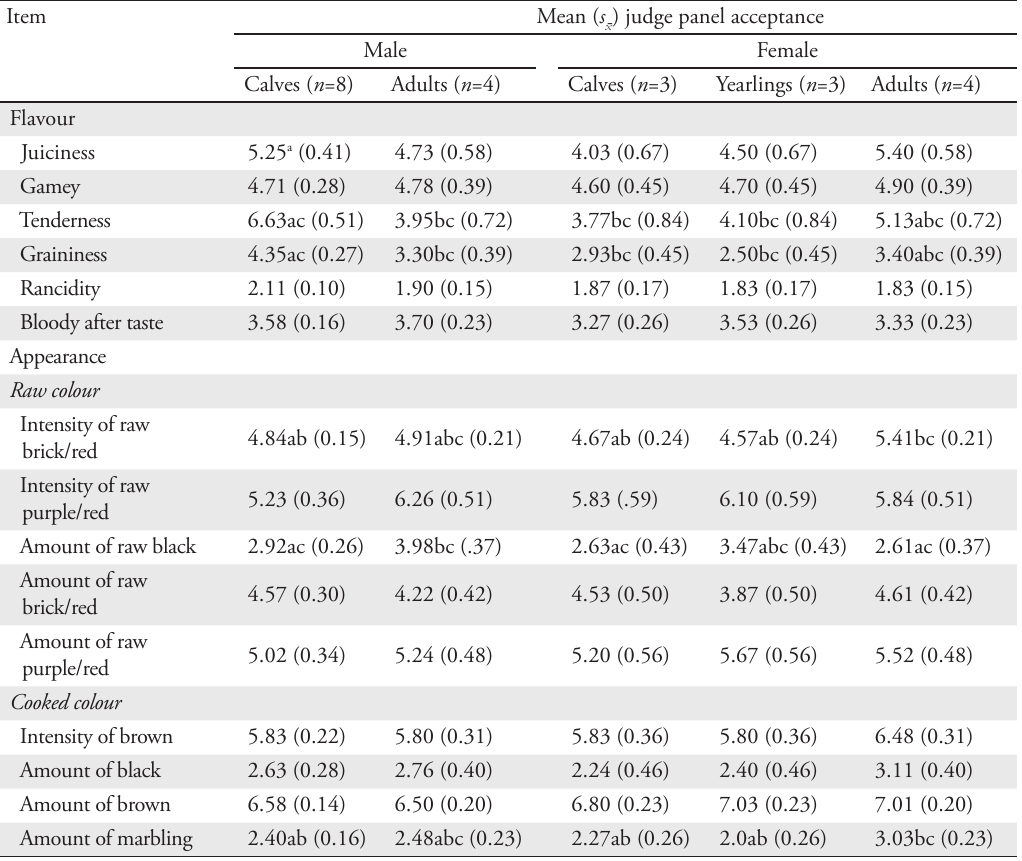
Table 4. Effect of sex and age cohort (calves, yearlings and adults) on mean (standard error of the mean, s colour profiles of loin steaks of free-ranging reindeer slaughtered on Nunivak Island, Alaska, January,